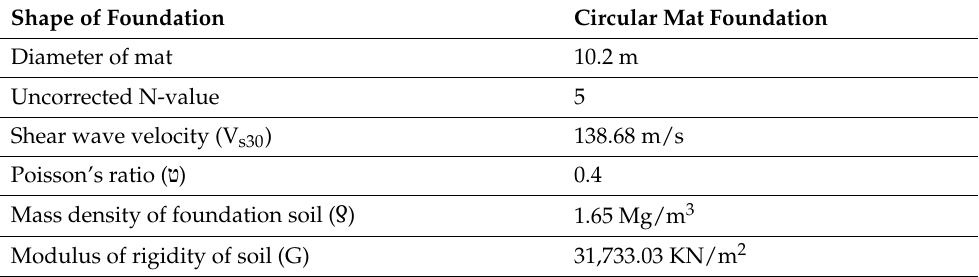
Table 4. Summary of parameters for modelling soil flexibility.